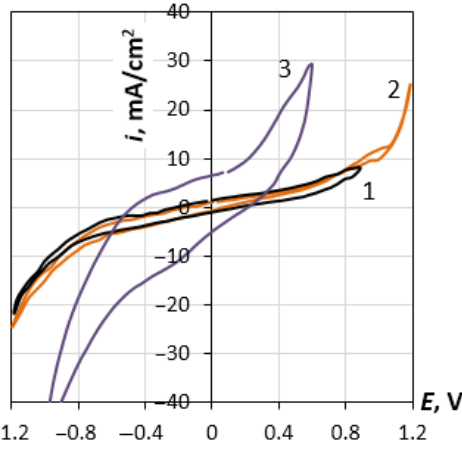
Figure 2. Voltammograms for Re electrode in molten KCl (1093 K). The scanning rate is 5 mVs − 1 (1), 10 mVs − 1 (2) and 50 mVs − 1 (3).